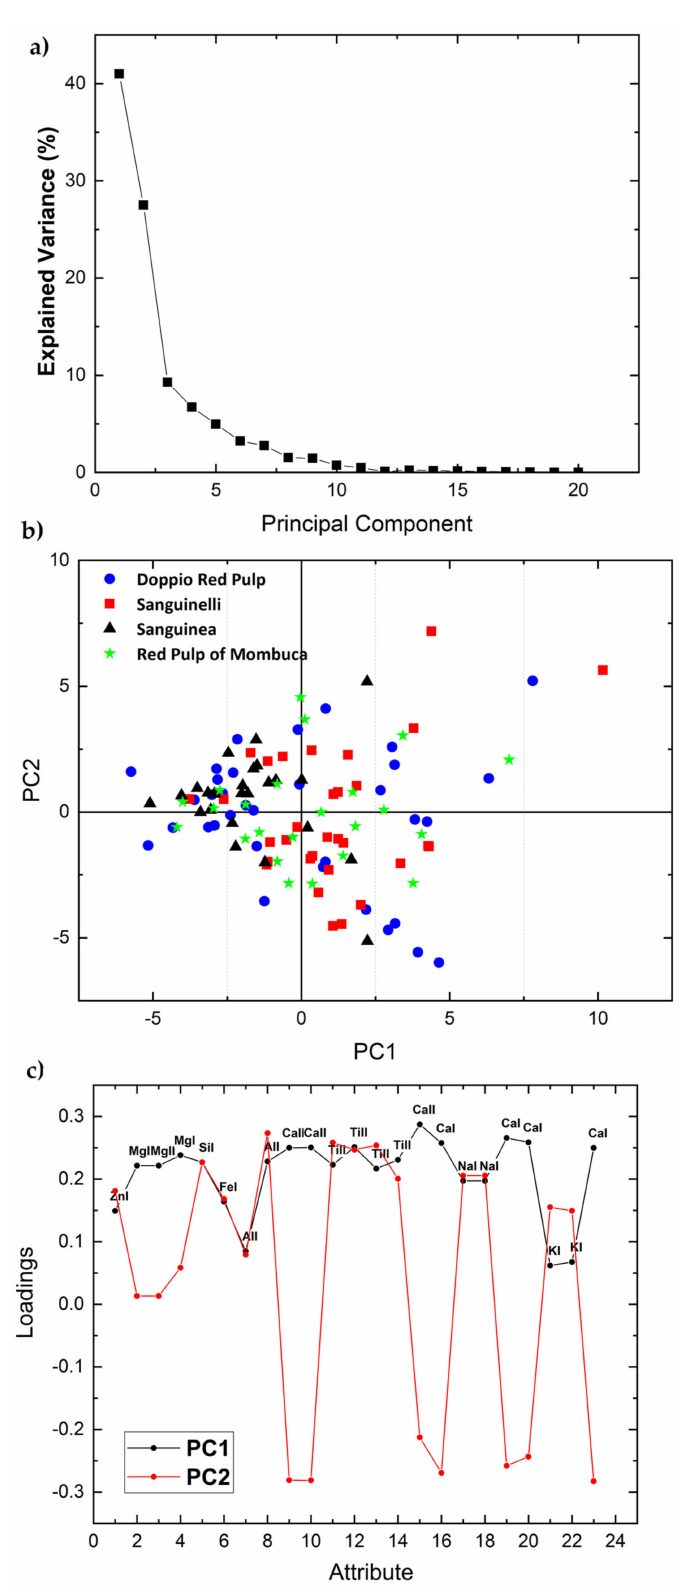
Figure 4. Scree plot ( a ), PCA 2-dimensional score plot of PC2 versus PC1 ( b ), and loading plot showing how each variable correlates to each PC ( c ) for the four accessions of the Pigmented Variety of set